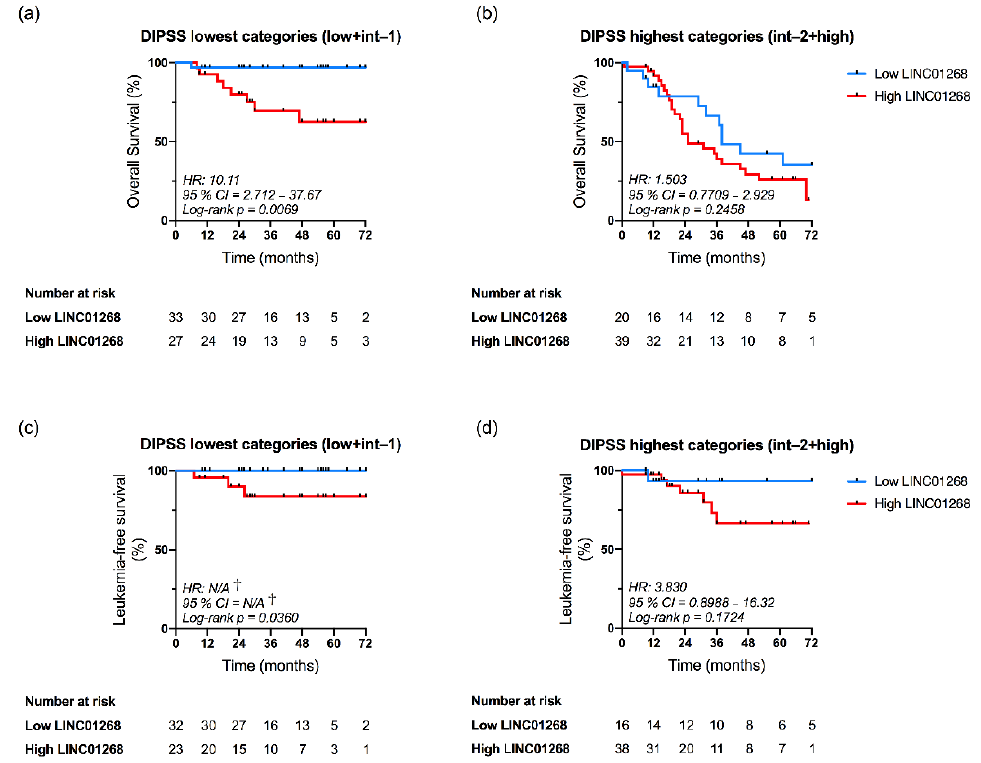
Figure 6. Kaplan–Meier analysis of Overall Survival ( a , b ) and Leukemia-free Survival ( c , d ) in the settings of DIPSS categories according to LINC01268 plasma levels. Patients were dichotomized in two subgroups according to DIPSS classification: lowest categories ( a , c ) correspond to Low and Intermediate-1 classes while highest categories ( b , d ) include Intermediate-2 and High groups. Patients’ cohort was then stratified according to low and high plasma levels of LINC01268, as previously described in the text. Differences between survival curves were evaluated by Log-rank (Mantel–Cox) test. Blue and red curves represent patients with low or high levels of circulating LINC01268, respectively. HR = hazard ratio computed to determine the magnitude of differences between two curves. † = No event occurred in the Low LINC01268 subgroup; p -value was computed by log-rank test; 95% CI = 95% confidence interval. Table 2. Results of multivariate regression analysis for overall survival and risk of transformation into acute myeloid leukemia. Analysis of the prognostic impact of high plasma level of each lncRNA was performed after stratification of samples according to DIPSS risk category. Significant p -value ( p < 0.05) are represented in bold. Overall Survival Transformation into Acute Leukemia Hazard Ratio (95%CI)